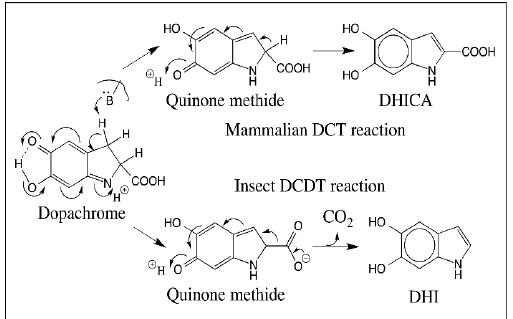
Figure 18. Reaction catalyzed by dopachrome converting enzymes. A base on the enzyme abstracts the β -proton on dopachrome causing isomerization of dopachrome to quinone methide. Quinone methide can readily exhibit another isomerization generating DHICA in the case of mammalian DCT. Since quinone methide is a β , γ -unsaturated acid, it can also readily exhibit decarboxylation. formation of DHI.